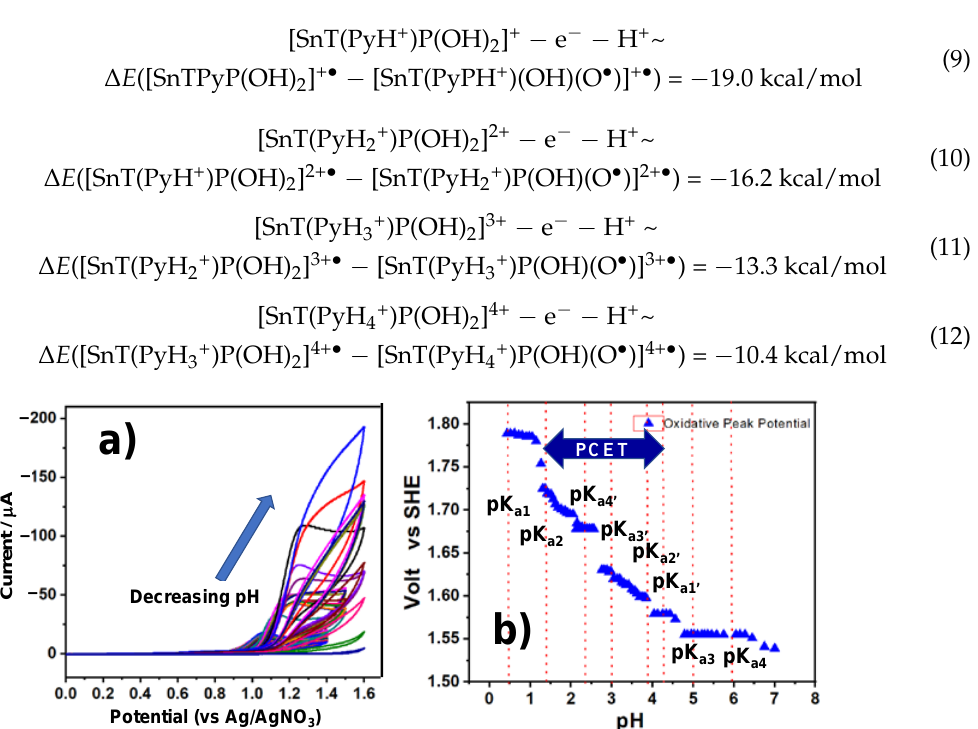
Figure 6. ( a ) Cyclic voltammogram of SnTPyP (0.2 mM in CH 3 CN/H 2 O (8/2, v / v )) in the presence of (C 4 H 9 N) 4 PF 6 (0.1 M) as an electrolyte with boron-doped diamond as the working electrode, Pt coil as the counter electrode, and Ag/AgNO 3 as the reference electrode, scan rate (100 mV/s), ( b ) Pourbaix diagram of SnTPyP under various pH conditions.